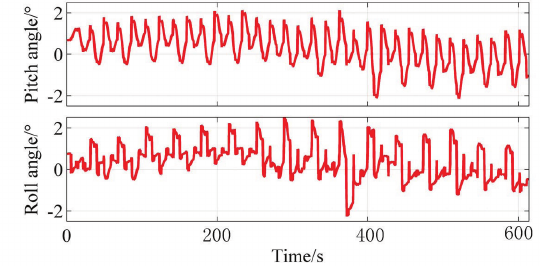
Figure 14. The intersection angle between robot base and horizontal